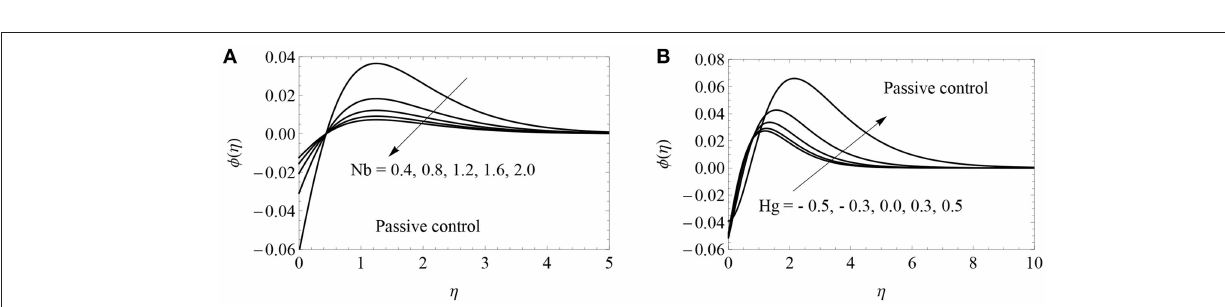
FIGURE 4 | Nanoparticle volume fraction profile of different values of Nb (A) and Hg (B) for passive case with K